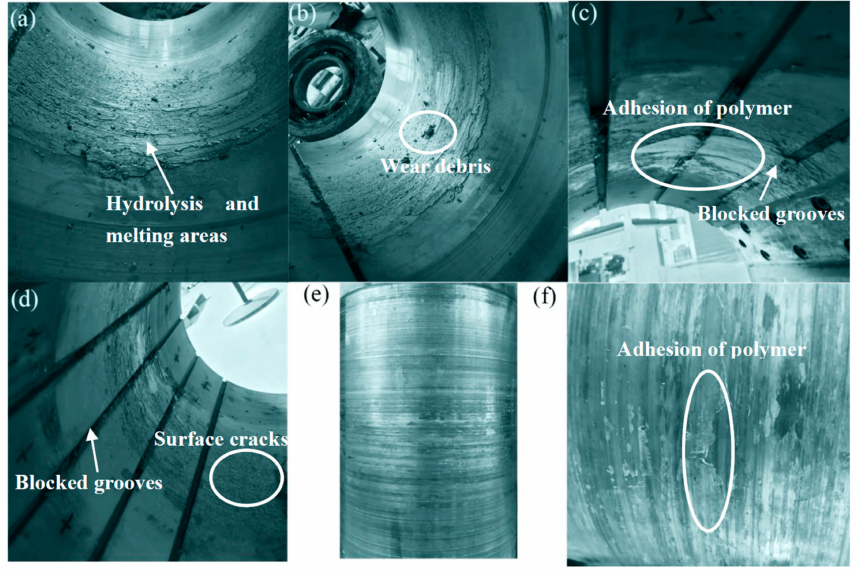
Figure 10. Picture of bearing surface and stern shaft surface after hydrolysis and melting. ( a , b ) Bear- ing loading area, ( c , d ) the blocked bearing grooves in non-load area. ( e ) Stern shaft surface and ( f ) enlarged view of ( e